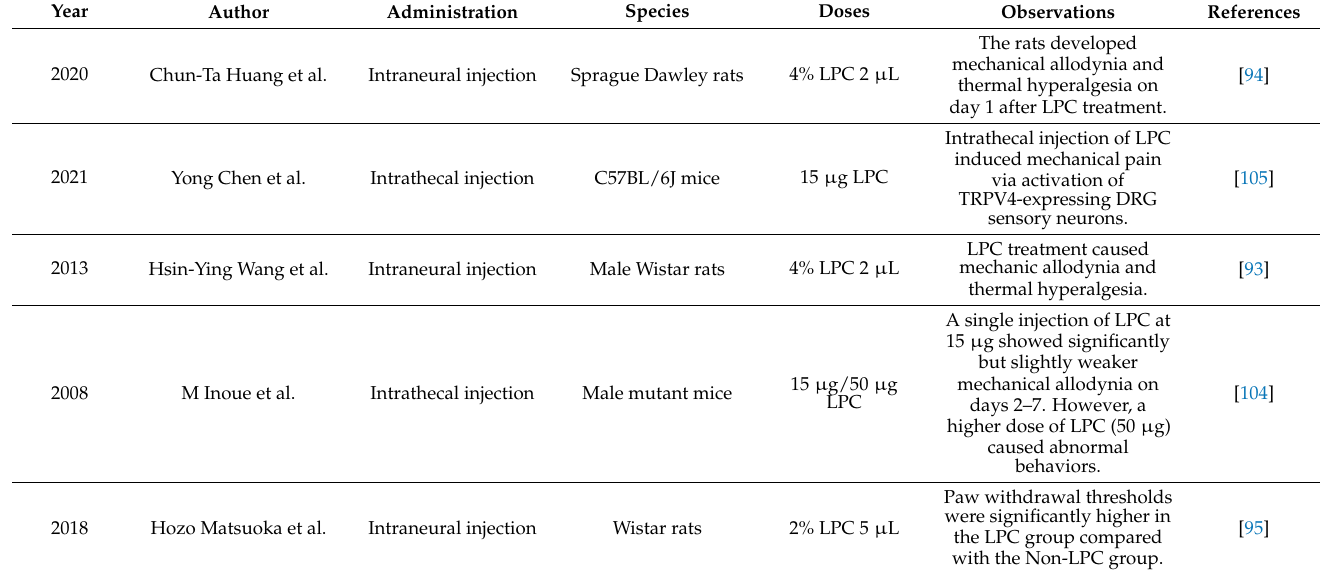
Table 3. The application of LPC in the construction of neuropathic pain